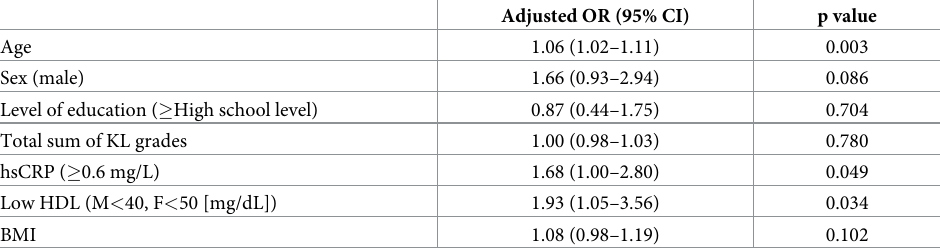
Table 2. Risk factors of rotator cuff tear in hand osteoarthritis using multivariate logistic regression analysis.